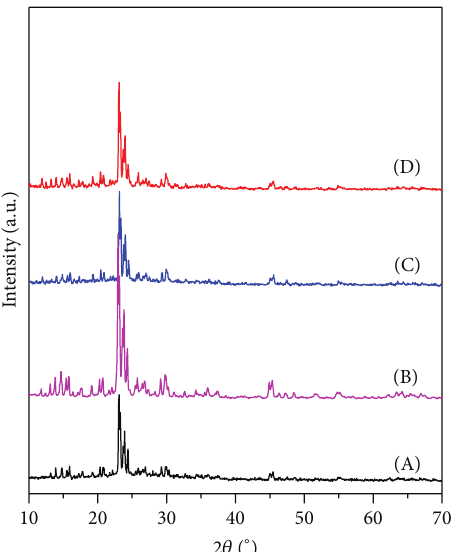
Figure 1: The XRD patterns of (A) H-ZSM-5, (B) 0.5 Zn/ZSM-5, (C) 1.3 Zn/ZSM-5, and (D) 2.7 Zn/ZSM-5.